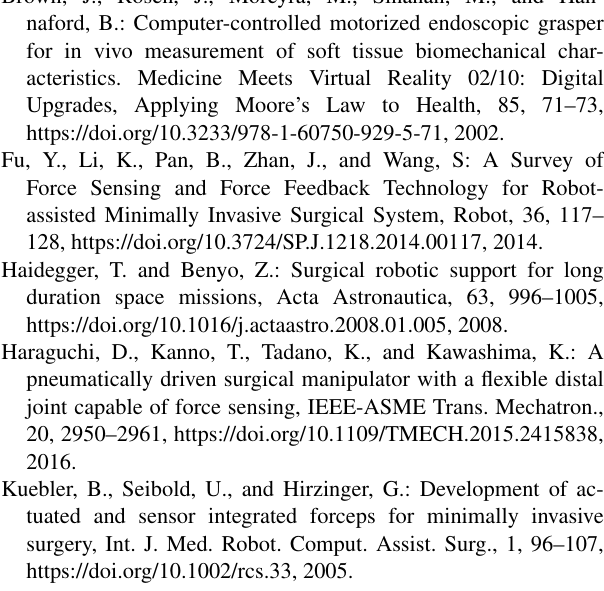
error range of the external forces estimation is about ± 0.1 N, with high accuracy of the force estimator. The estimated ac- curacy can reach up to 94 % for an external force greater than 1 N, and the estimated accuracy can reach 82 % for an exter- nal force of 0.3 N. The external force has little influence on the joint angle control precision. The greatest error was 1.25